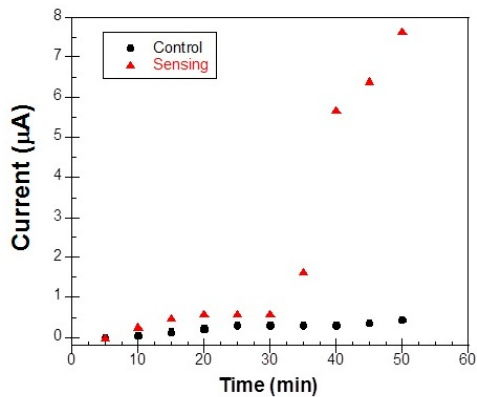
bars were determined from repeating the measurements on the same electrode at least three times.